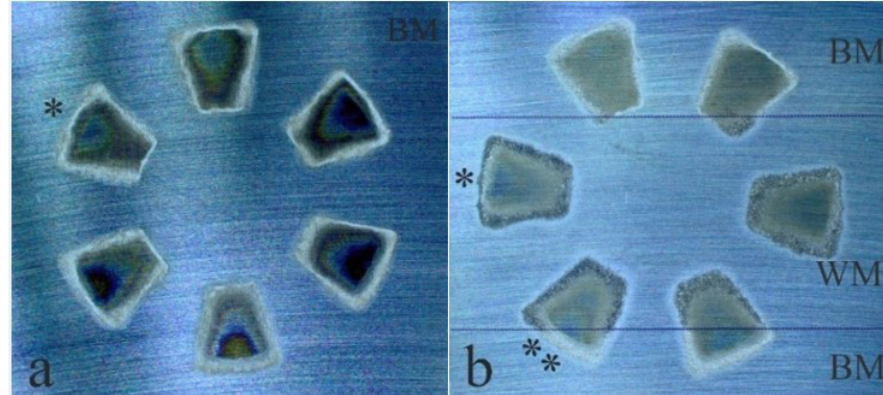
Figure 10. Macrograph of the surface samples in crevice corrosion tests in NaCl 3.5% wt. solution a. Base metal (BM), b. Base metal- weld metal